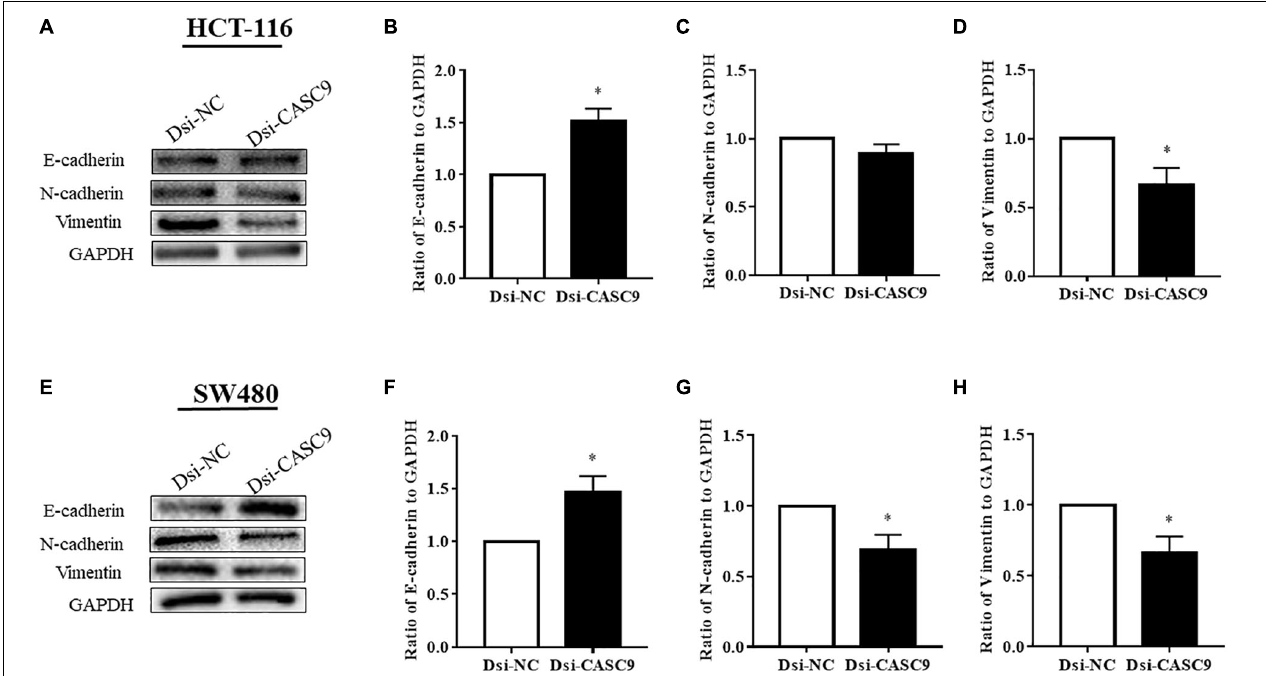
FIGURE 6 | CASC9 silencing altered the expressions of EMT marker proteins in CRC cells. The EMT markers E-cadherin, N-cadherin, and vimentin were evaluated by Western blotting in HCT-116 (A–D) and SW480 cells (E–H) . In both cell lines, CASC9 significantly upregulated E-cadherin and downregulated vimentin expressions. The N-cadherin expression was also downregulated but did not reach statistical significance in HCT-116 cells. The data are shown as mean ± SEM using GAPDH as housekeeping gene (* P < 0.05, and n =